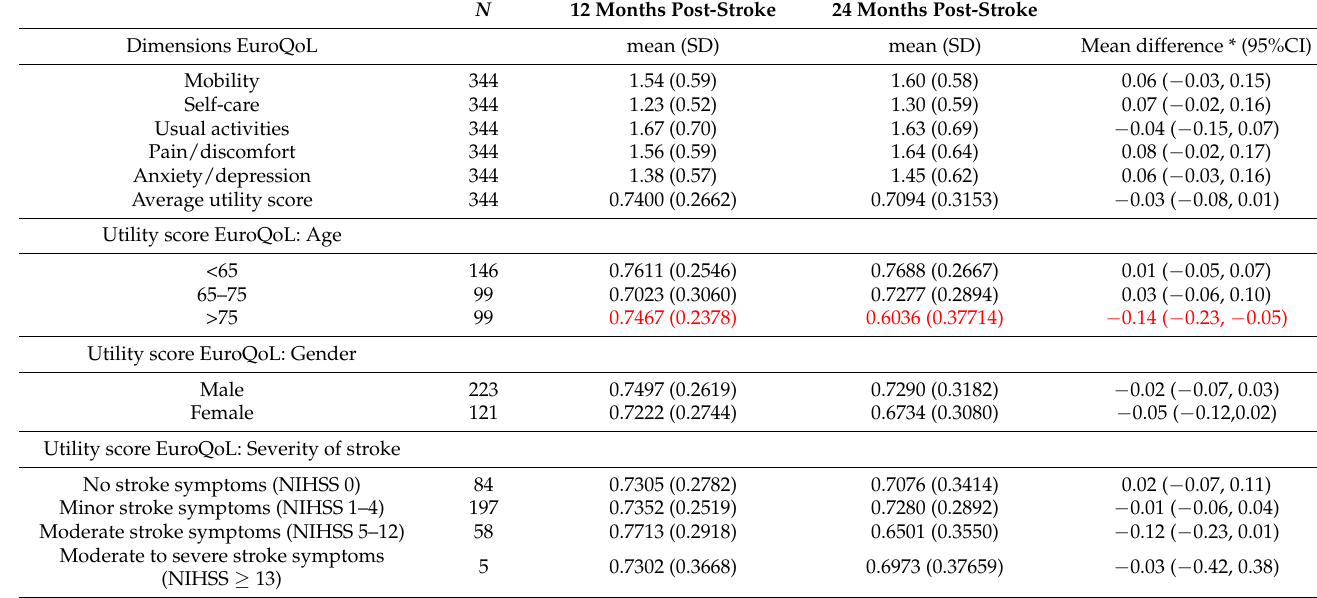
Table 4. EQ-5D-3L dimensions and Dutch utilities at 12 months and 24 months post-stroke ( n =